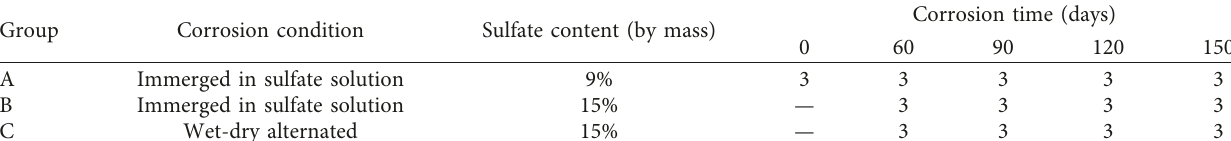
Figure 7: Size of the specimens. Table 4: Grouping and testing